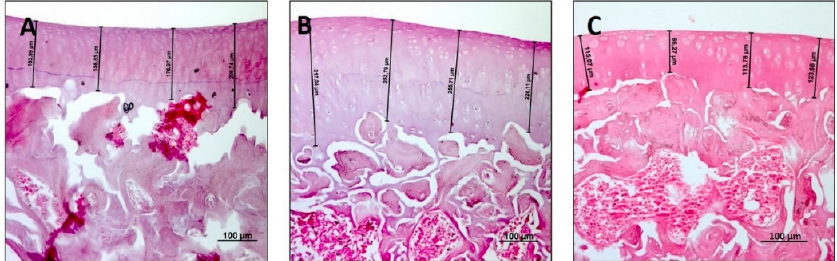
Figure 1. Histological evaluation and histomorphometric analysis of articular cartilage by hematoxylin and eosin (H&E) staining. ( A ) R group (control). In the superficial zone of the articular cartilage, chondrocytes were flat and small; in the middle and deep zone, cells were organised in columns; the tidemark was very strong and evident; ( B ) R-DS group. General tissue preservation was observed in the superficial, middle and deep zones; the tidemark was a little bit less evident, and the deeper zone above the tidemark was very thick; ( C ) R-DR group. Articular cartilage did not show evident alterations; in middle and deep zones the chondrocytes were poorly organised in columns, and the tidemark was not always perceptible. ( A – C ) Objective lens, 10; scale bars: 100 μ m. These are the most representative images of articular cartilage from rats of each group (R, R-DS and R-DR). Table 2. THICKNESS—Articular cartilage.